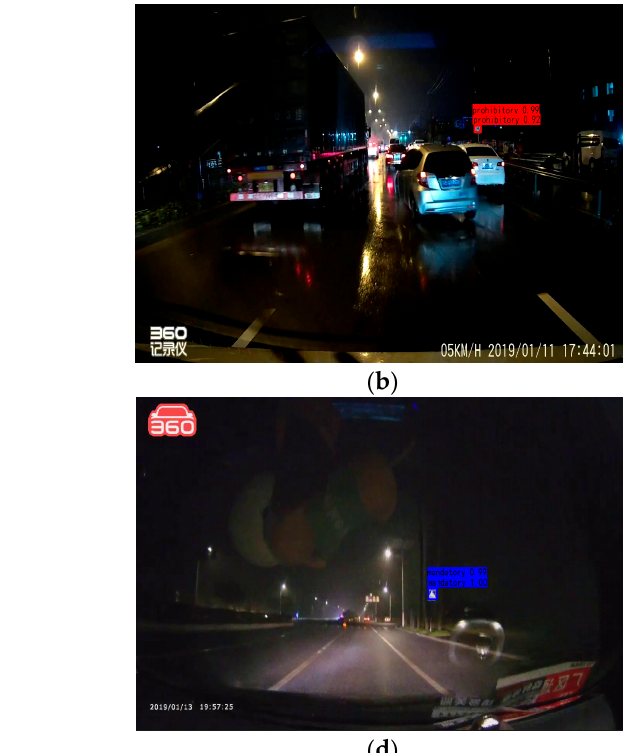
Figure 15. Comparison results of different algorithms in a night scenario, where ( a , c ) are the results of TSR-YOLO, ( b , d ) are the results of YOLOv4-tiny.